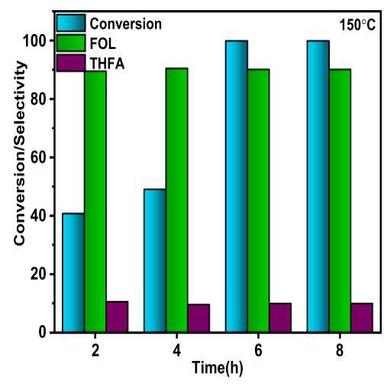
Effect of variation of temperature on conversion/selectivity. Fig. 10. Effect of variation of contact time on conversion/selectivity.